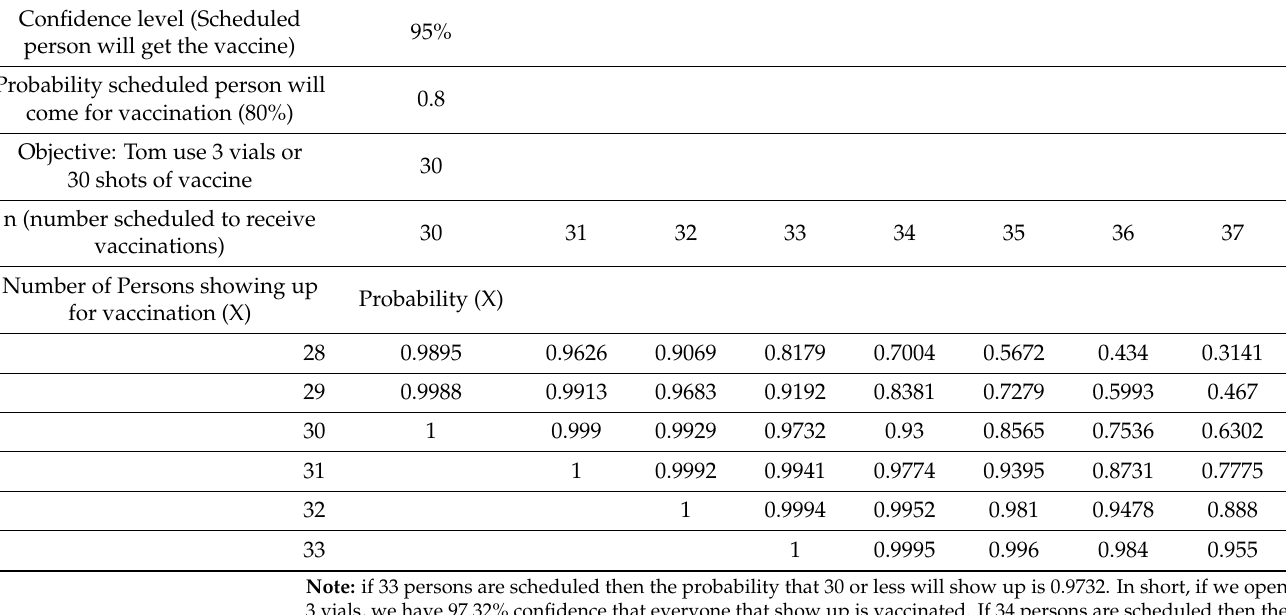
Table 1. Binomial function for calculating probabilities for optimal utilization of